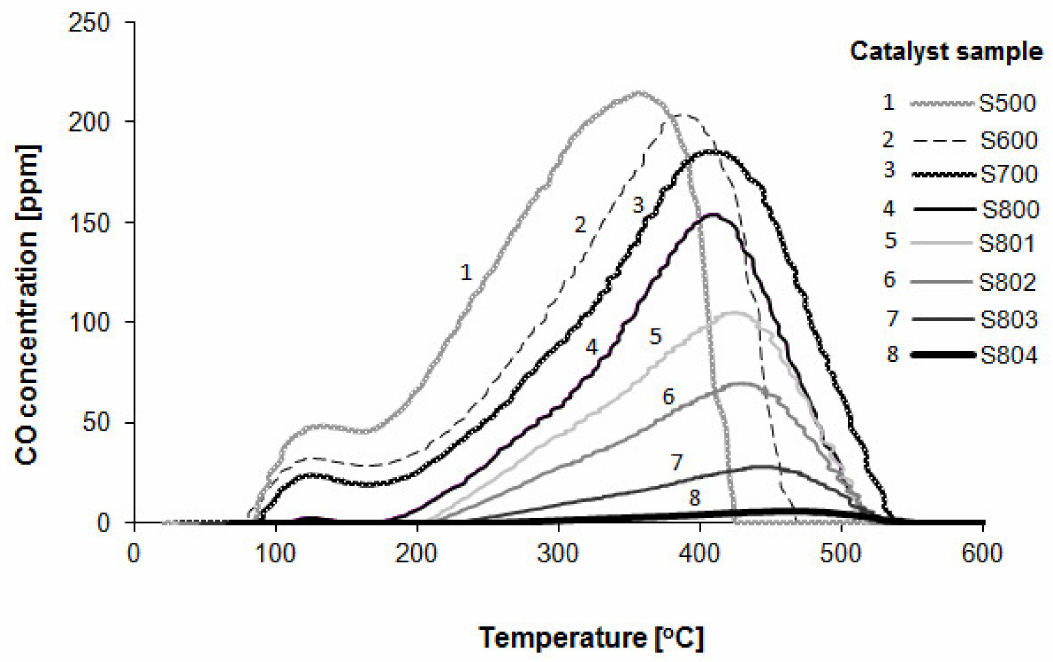
Figure 5. TPD-CO profiles for the 1%Pt/Al 2 O 3 catalysts depending on their reduction temperature. All samples reduced at 800 ◦ C show single-stage CO desorption, starting at about 200 ◦ C and reaching a maximum in the range of 400–460 ◦ C, depending on the sample’s pretreatment. The absence of the low-temperature desorption stage seems to indicate that on the sample reduced at VHRT, the adsorption of CO in bridge form does not take place. CO desorption for samples reduced at temperatures lower than 800 ◦ C begins at a temperature of around 100 ◦ C, corresponding to that in which the process of CO oxidation over the Pt/Al 2 O 3 catalyst operating in oxygen excess at atmospheric pressure starts (the results are not shown here). As was previously stated, carbon monoxide behaves as